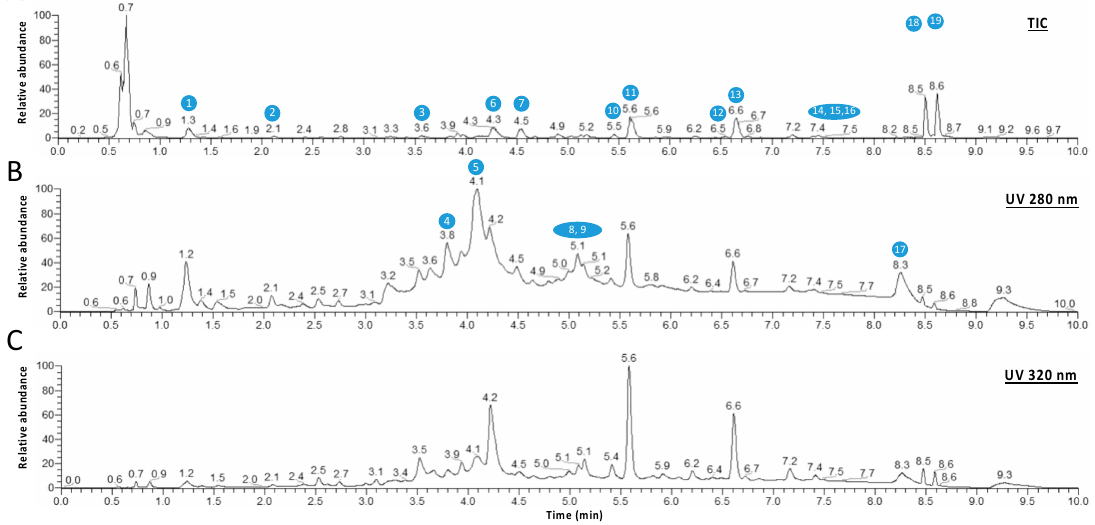
Figure 1. Spectra obtained for a representative P. mauritianum aqueous extract. ( A ) Representative total ion chromatogram (TIC) obtained in negative mode. ( B ) UHPLC-UV chromatograms obtained at 280 and 320 nm. ( C ) The different molecules are numbered according to their retention times. Note that numbers in blue correspond to the peak numbers reported in Table 2. Identification and quantification of compounds from aqueous extract of P. mauritianum (0.25 g/L) by LC-MS/MS analysis. Spectra analysis was also performed (upper spectrum: representa- tive total ion chromatogram (TIC) obtained in negative mode; lower spectrum: HPLC-UV chroma- togram obtained at 280 and 320 nm). Results are expressed as mean in ng/mL. RT, retention time. Nq, not quantified. Note that numbers correspond to the ones shown on the different spectra from Figure 1 (peak numbers reported in the table). Note that some isomers were detected (e.g., kaempferol hexoside). Peak number RT (min)